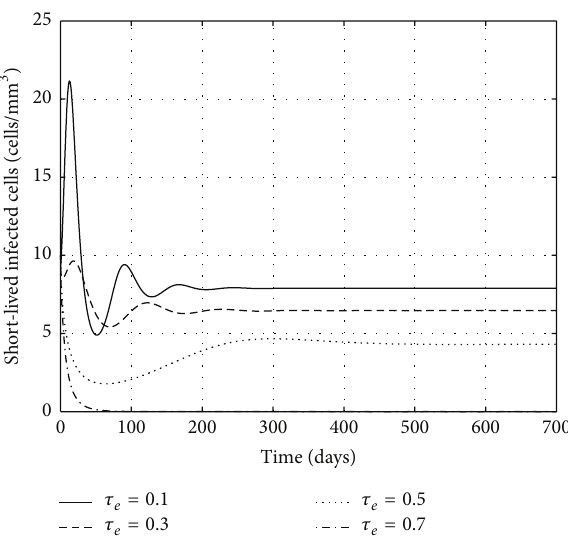
Figure 12: The concentration of short-lived infected cells for model